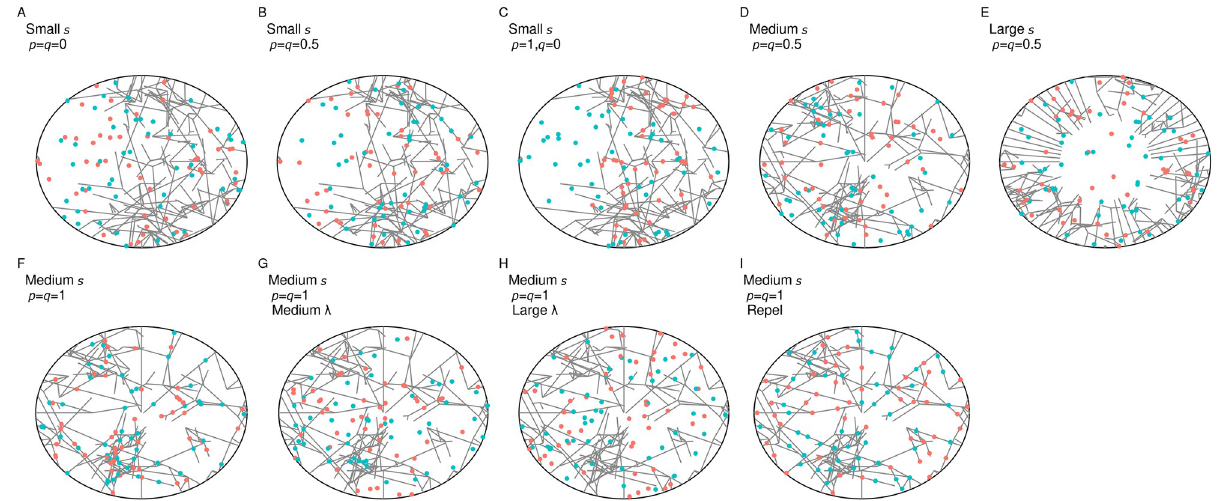
Fig 1. Snapshots of computationally generated networks and mtDNA arrangements with tunable physical and genetic parameters. Networks were generated by an elongation and branching process initialized from a number of seed points ( s ) uniformly distributed on the perimeter of the cell. Small seed numbers s (A-C) usually resulted in heterogeneous network structures, with marked differences in network density across the cell; for increasing seed numbers (D-F), networks were more uniformly distributed throughout the cell. Wild type (WT; red) and mutant type (MT; blue) mtDNA molecules were distributed into networks according to the proportions p (WT) and q (MT). In different model variants, diffusion with scale parameter λ was applied to mtDNAs prior to division to model network fragmentation and subsequent motion (G-H; original network shown for reference), and mtDNAs were placed with a repulsive interaction inducing greater-than-random spacing